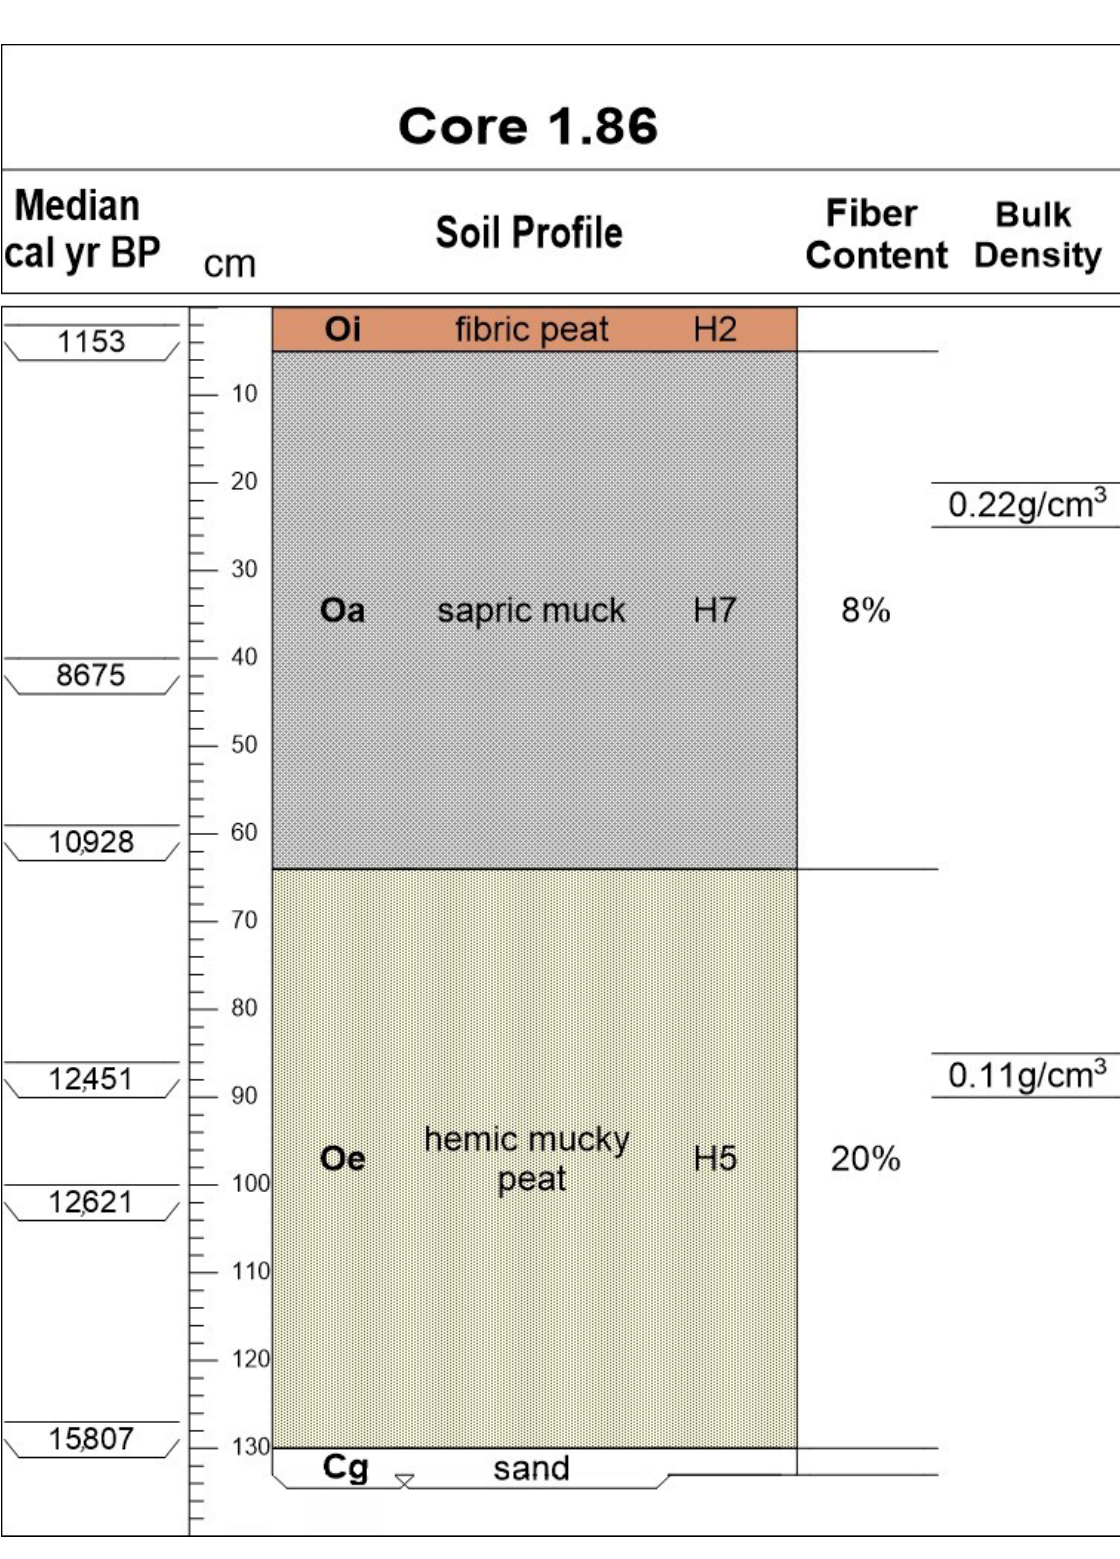
Figure 5. Soil profile of Core 1.86, representing Type B (SH) profiles.